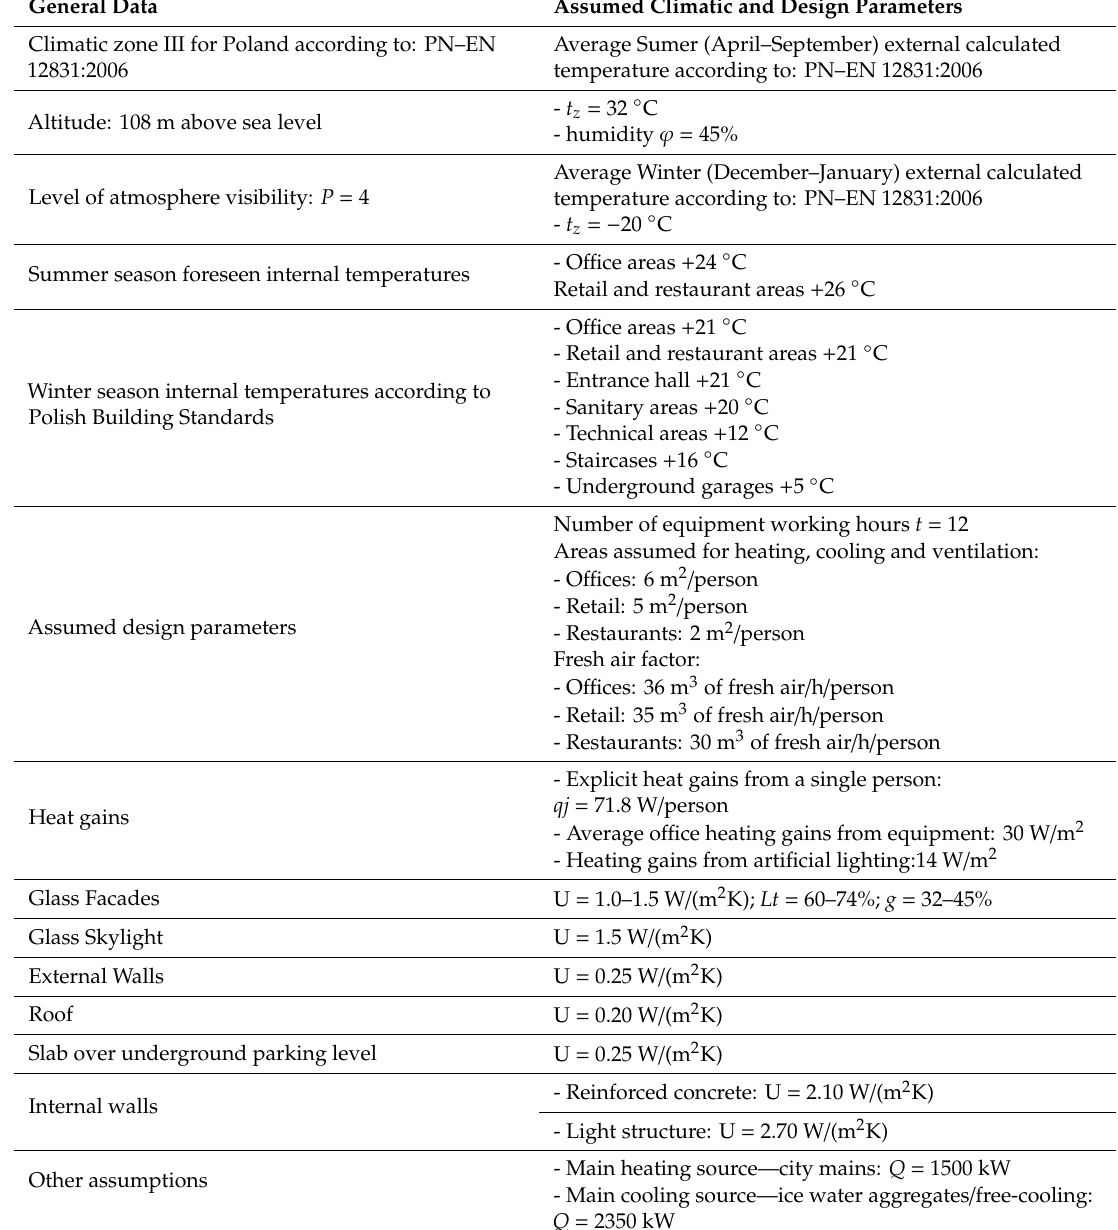
Table 1. Initial design